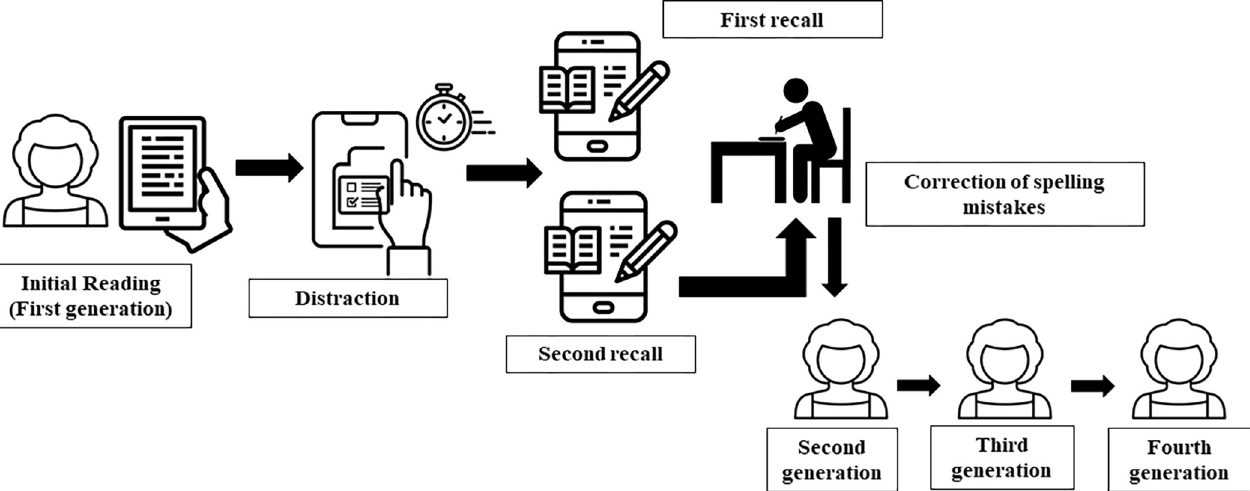
Fig 4. Representation of the information transmission experiment through a linear transmission chain. Figure based on the protocol adapted from Jime´nez et al. [31].